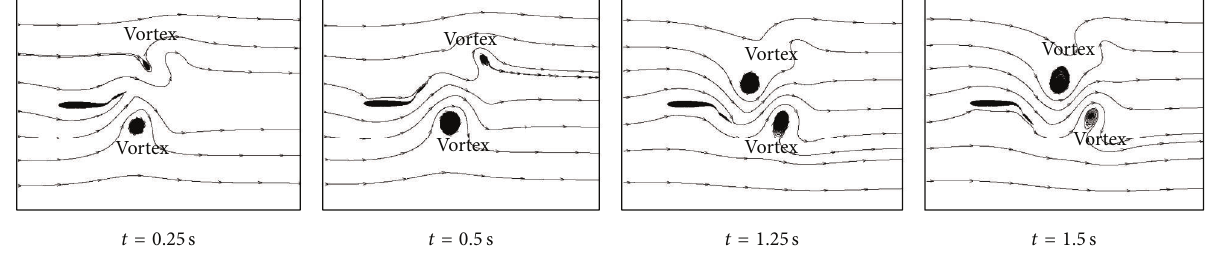
Figure 10: Trailing vortex at 𝜑 = 0 ∘ .